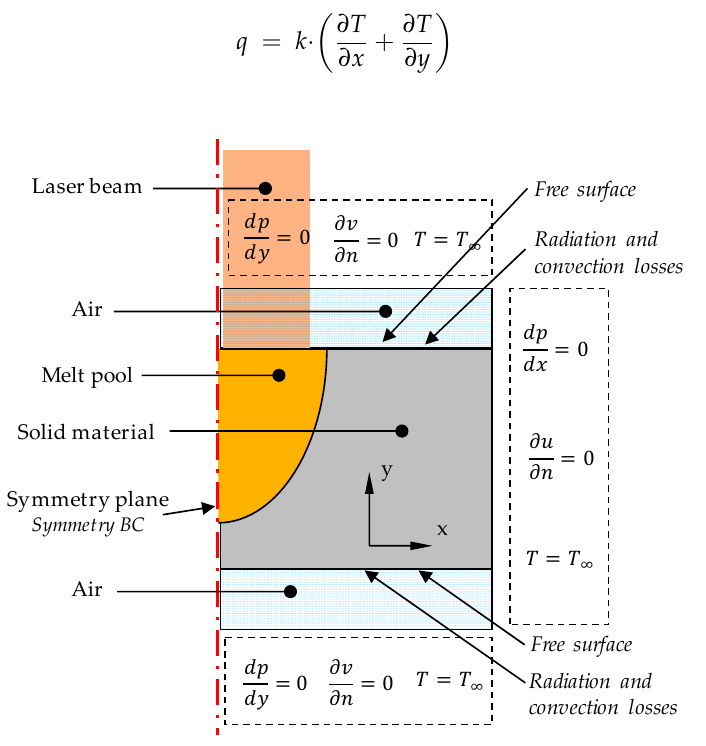
Figure 2. Applied boundary conditions for modeling the welding process.